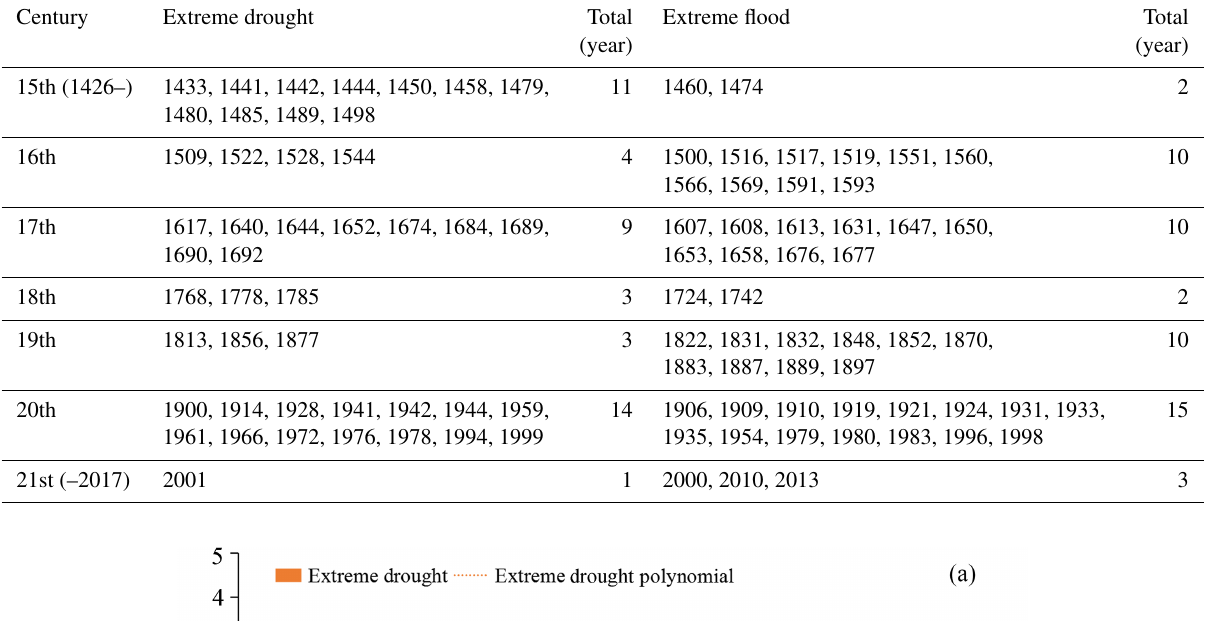
Table 3. Statistics on historical extreme droughts and floods per century for 1426–2017.